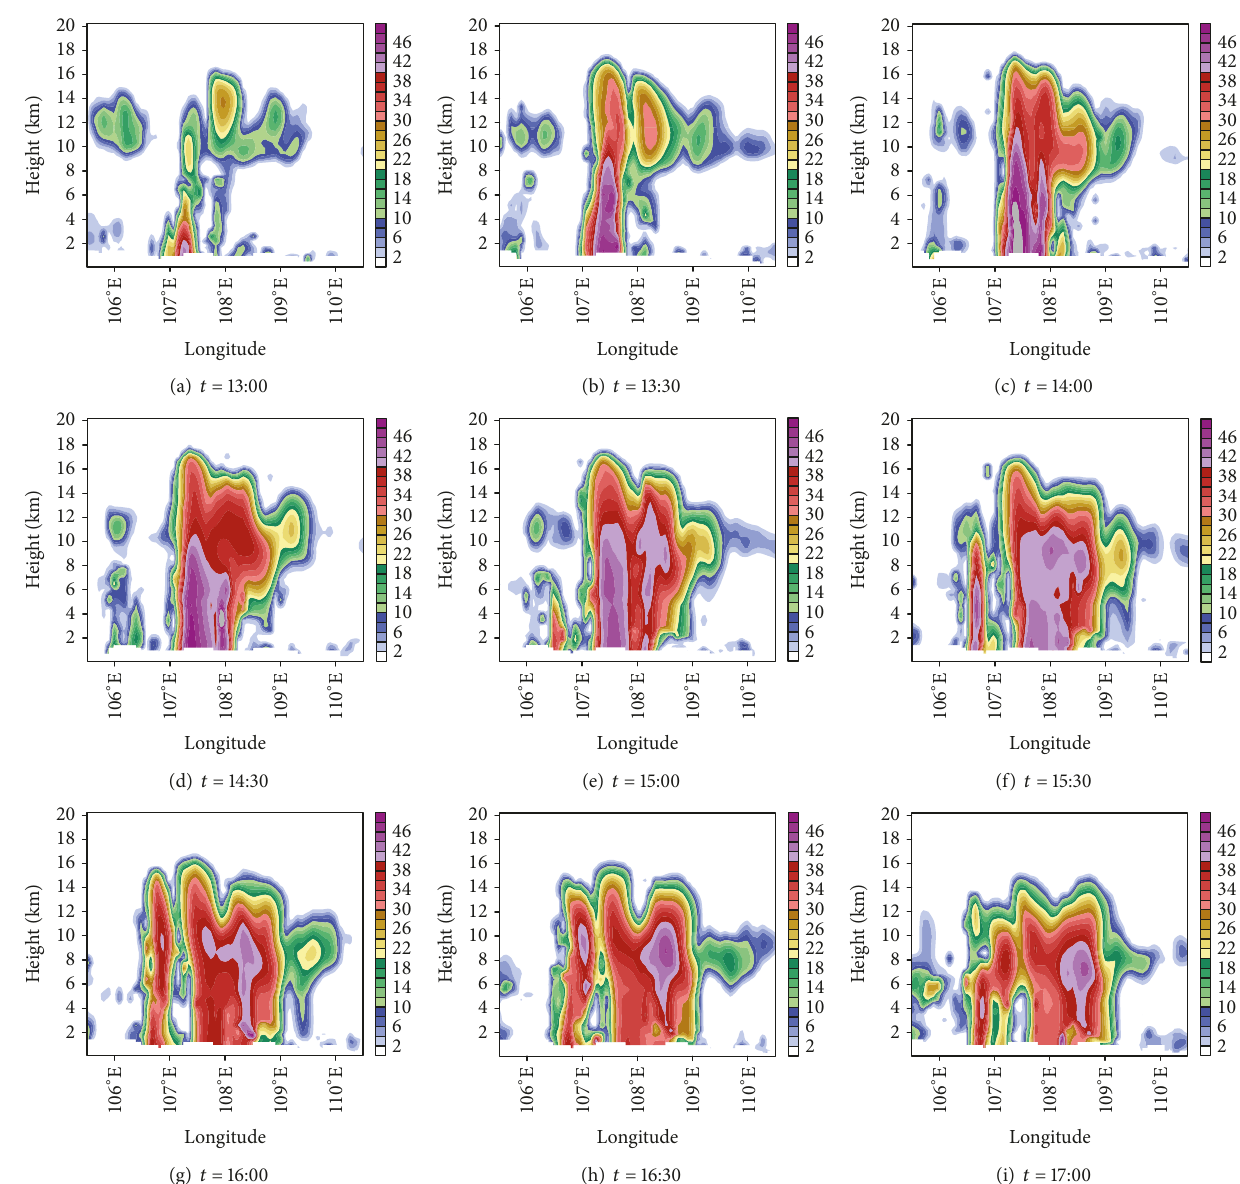
Figure 5: Zonal cross-section of the evolution of reflectivity (unit: dBz) along 25.4 ∘ N from the WRF